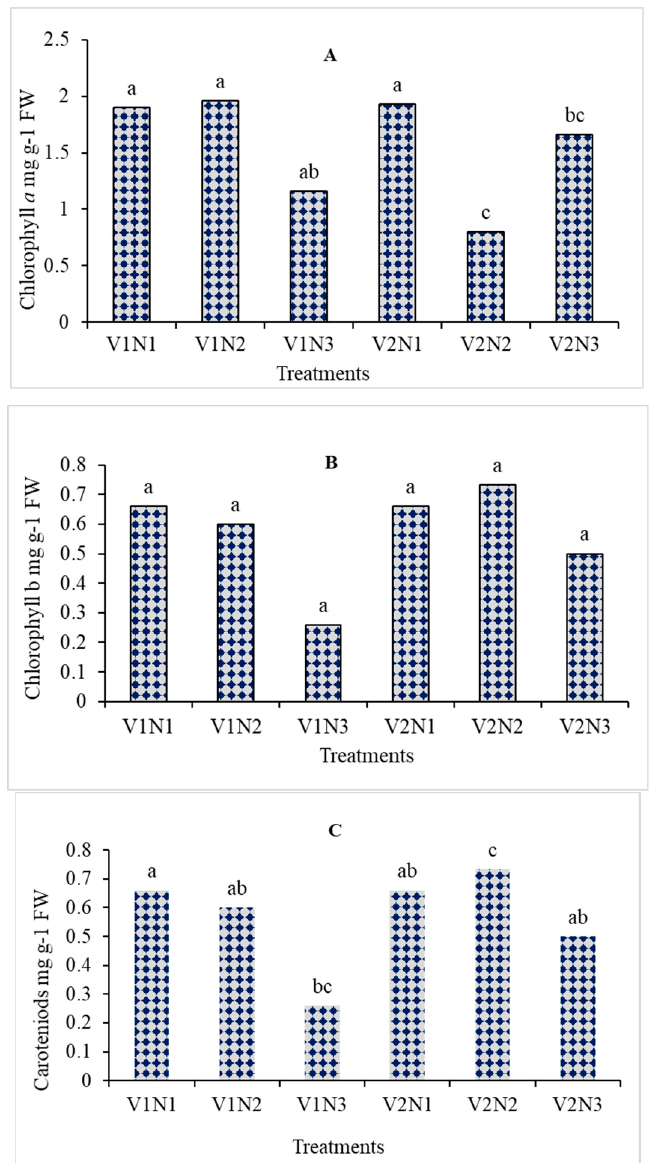
Figure 1. Effects of N rates on ( A ) chlorophyll a content, ( B ) chlorophyll b content, and ( C ) carotenoids, of two sorghum varieties. Different lowercase letters on the bars in the figures represent statistical difference at the 0.05 probability level by an ANOVA-protected test.